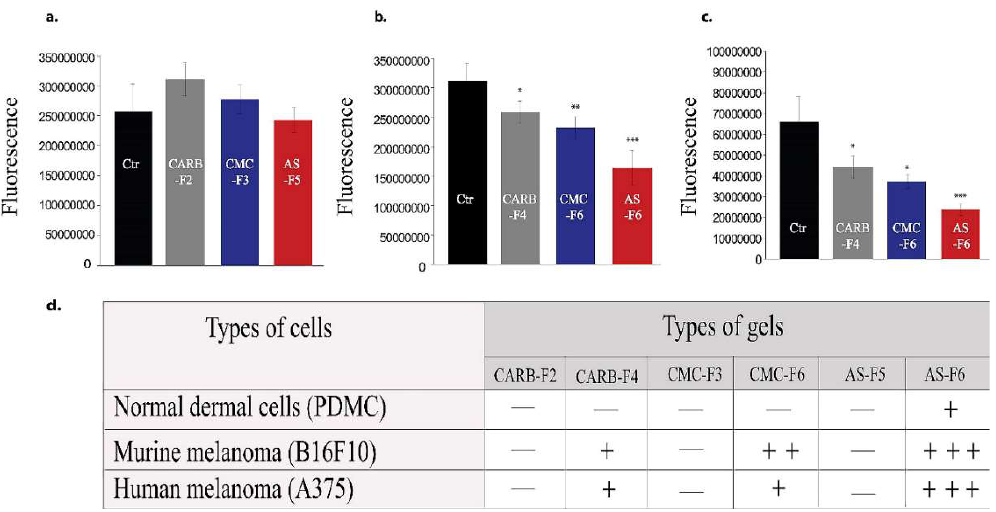
Figure 6. Murine and human melanoma cell viability for gel formulations without ( a ) and with ( b , c ) CD-NHF (conc. 5%). N = 15 wells/column from two independent experiments; viability of treated groups is expressed relative to the control group. ( a ) Skin cancer; ( b ) murine melanoma (B16F10); ( c ) human melanoma (A375); ( d ) scoring of significance effect, where +++ (***) p = 0.0003, ++ (**) p = 0.01, + (*) p = 0.04, and — = no effect.